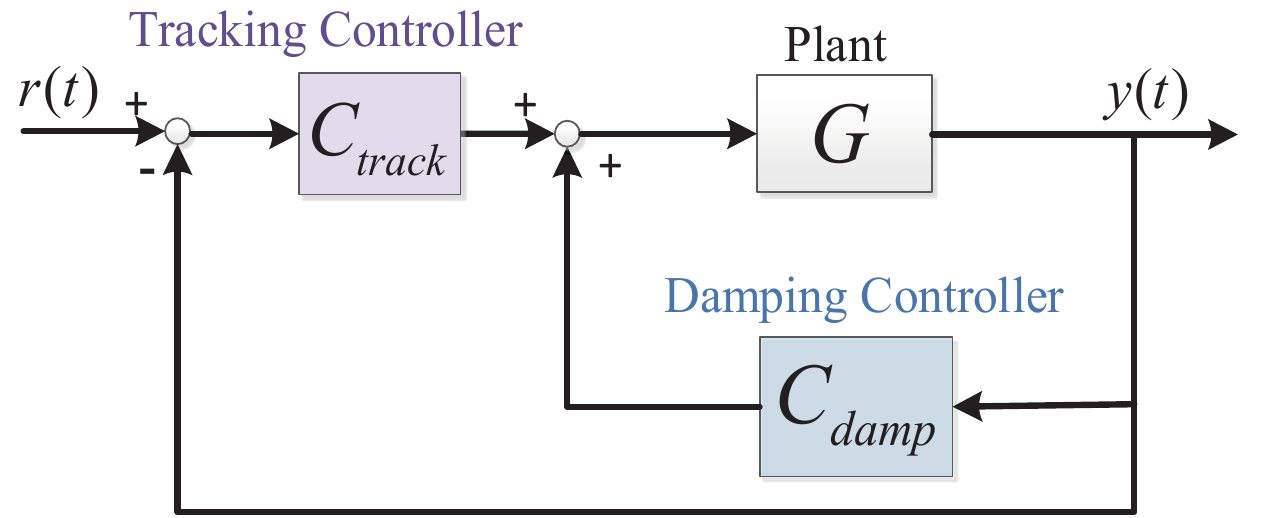
Figure 1. Block diagram of the traditional dual-loop damping and tracking control scheme employed in precision positioning applications. In the context of this work, the damping controller is one of PPF/ PVPF/ PAVPF family and the tracking controller is an adequately gained